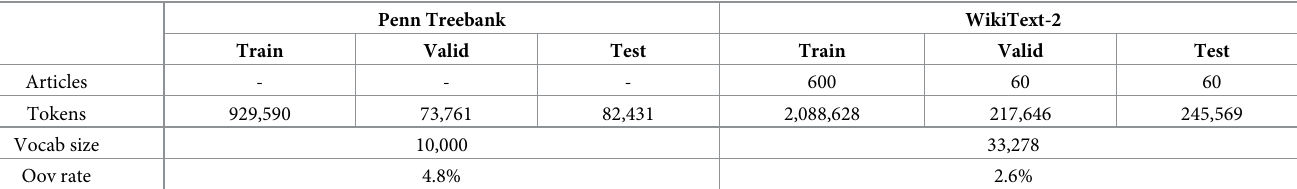
Table 1. Statistics information of the PTB and WikiText-2 datasets.